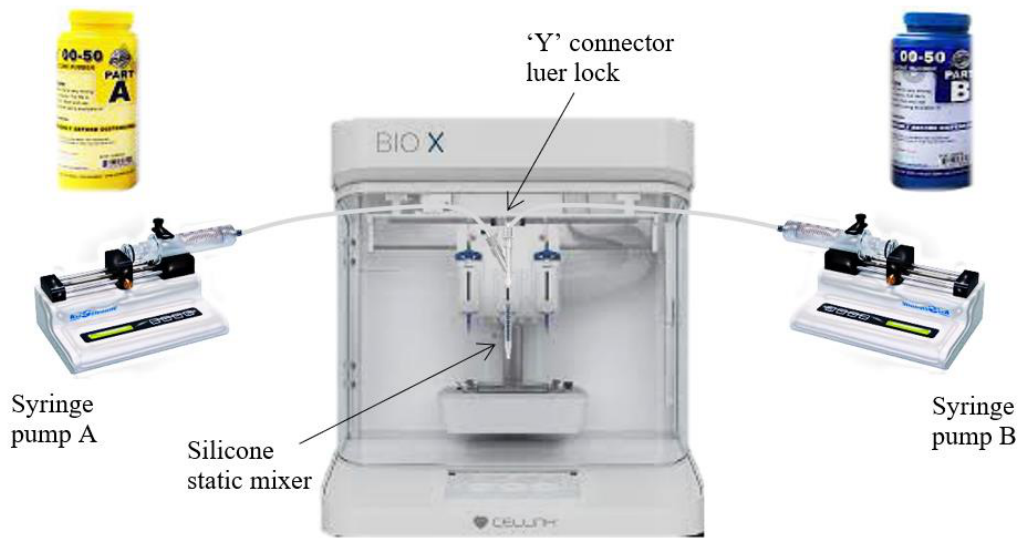
Figure 2. 3D-printed mold and silicone modules.